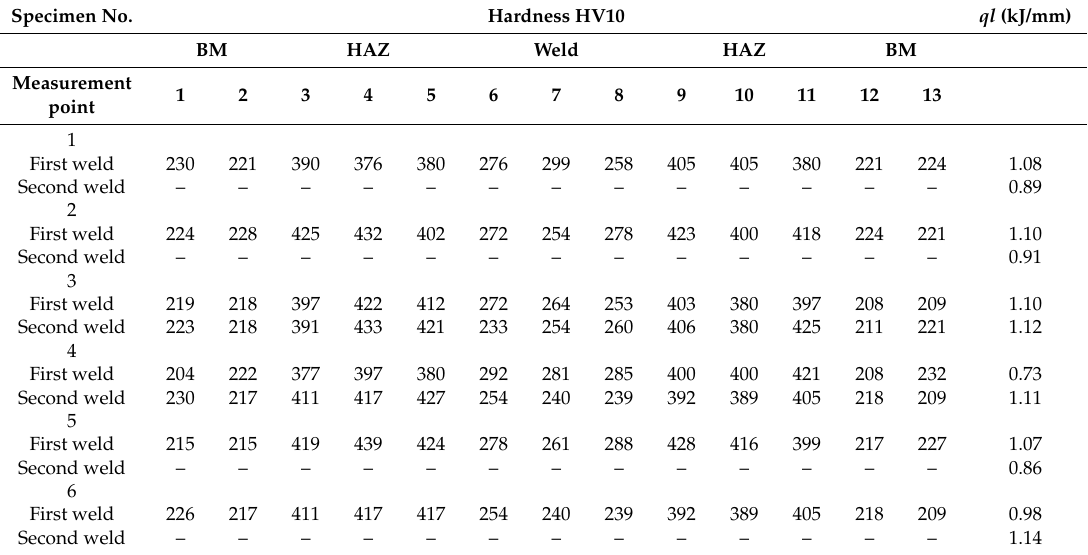
Table 5. Results of hardness measurements—CTS specimens.